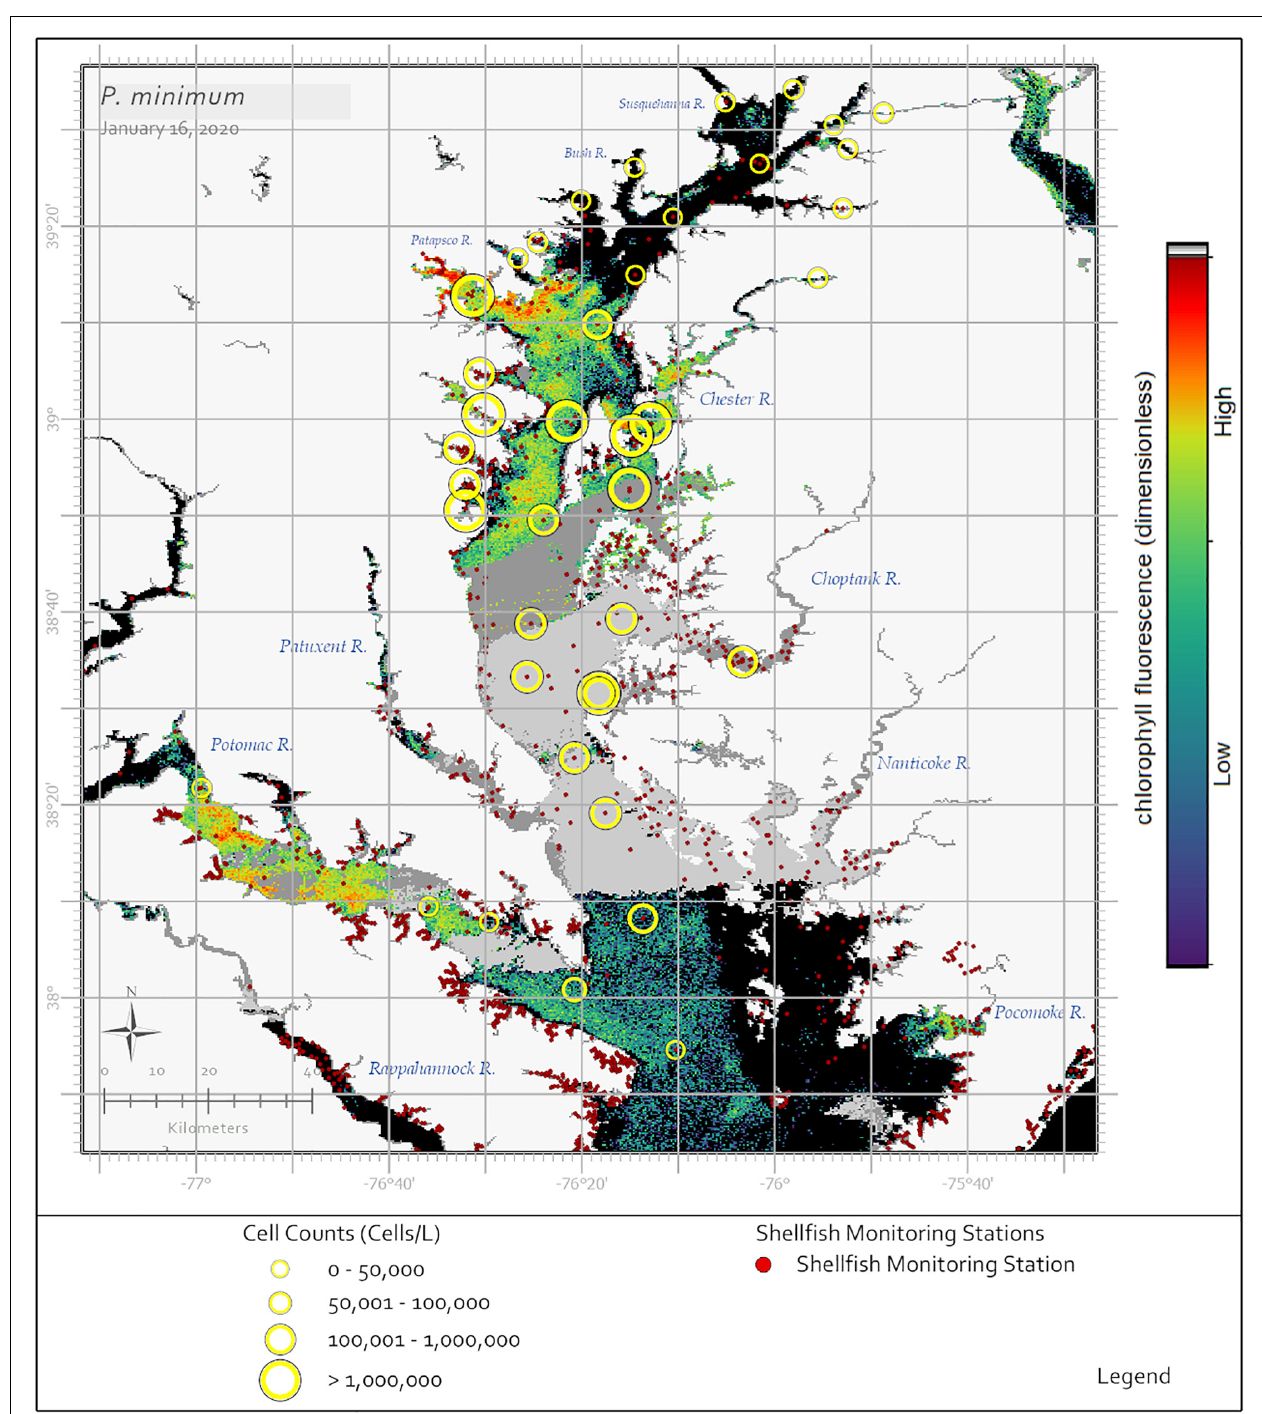
FIGURE 4 | Sentinel-3a OLCI image with RBD algorithm captured on January 16, 2020 showing a bloom of the dinoflagellate P. minimum throughout the Maryland portion of the Chesapeake Bay. In situ data indicated a widespread P. minimum bloom, however, the satellite ocean color data collected during this time were limited by cloud cover. Yellow circles indicate cell concentrations determined using light microscopy for samples collected January 13–16, 2020, with symbol size representing cell concentration ranges. Medium and dark gray pixels represent no retrievals due to clouds. Black pixels indicate no bloom detected. The dark red dots indicate shellfish growing area classification